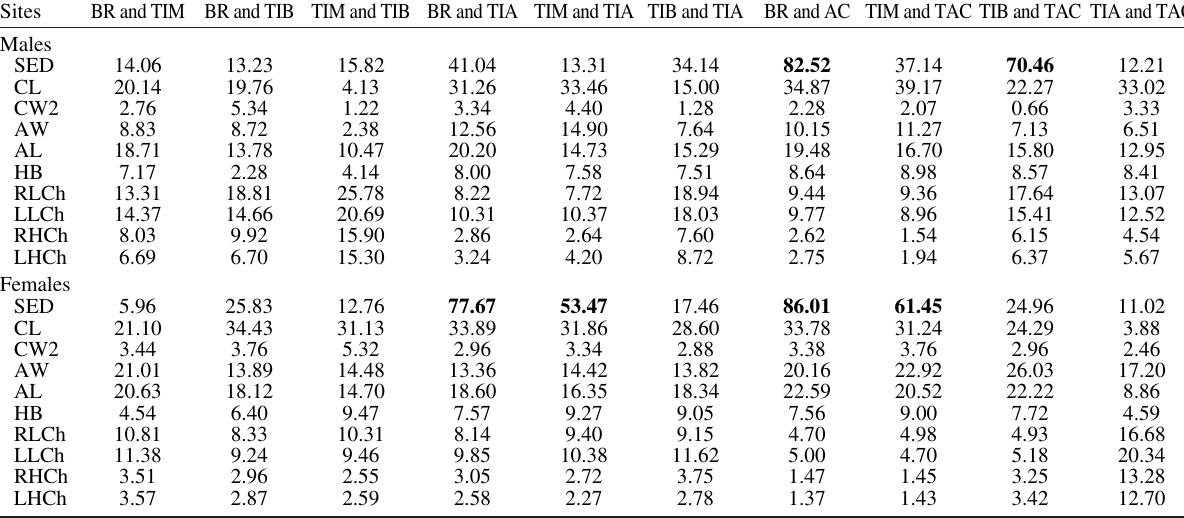
Table 4. – Results of the SIMPER analysis showing the average squared Euclidean distance (SED) and contribution percentage of each morphometric variable of Aratus pisonii to dissimilarity between sites for each sex. The SED that have the highest dissimilarity (>50) between each pair of sites are placed in bold. Sites BR and TIM BR and TIB TIM and TIB BR and TIA TIM and TIA TIB and TIA BR and AC TIM and TAC TIB and TAC TIA and TAC Males